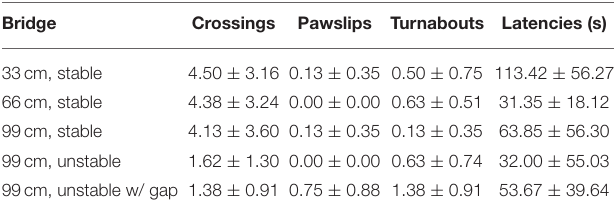
TABLE 3 | Mean ( ± SEM) number of the performances on the different bridges in Group 3 (WT adolescent rats grown up with WT adolescent rats). Bridge Crossings Pawslips Turnabouts Latencies